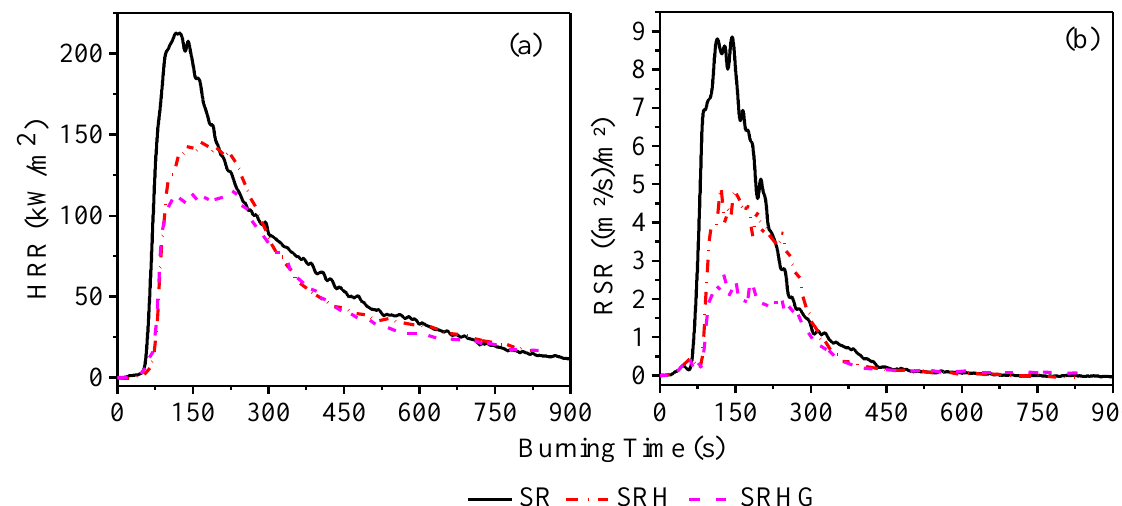
Figure 3. Combustibility of RTV samples ( a ) heat release rate (HRR) and ( b ) rate of release of smoke (RSR).